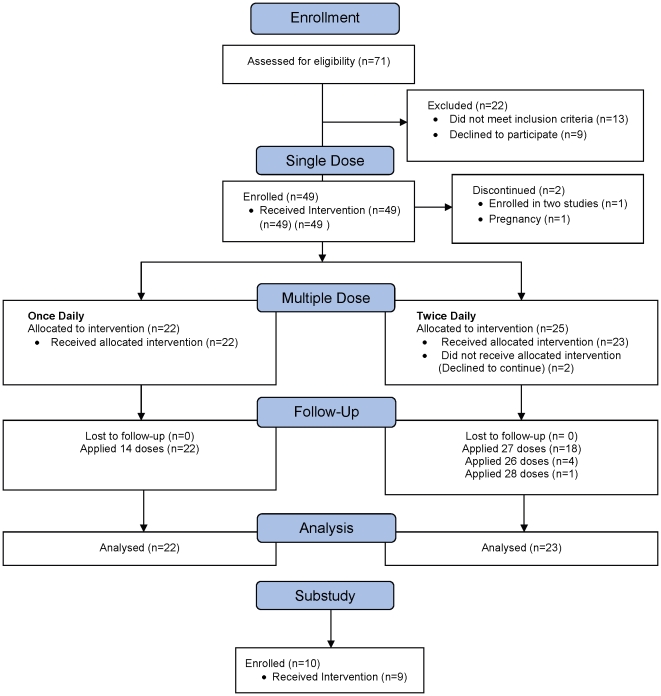
Participant flow diagram.